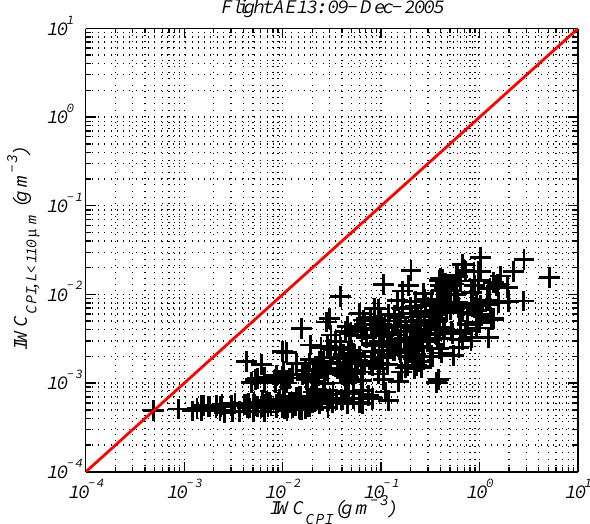
Fig. 4. Relative contribution of small ice crystals (maximum dimen- sion L < 110µm) to total IWC as determined with the SPEC CPI. It can be seen that the contribution from the small crystals is only significant at extremely low total IWC ( < 0.01gm − 3